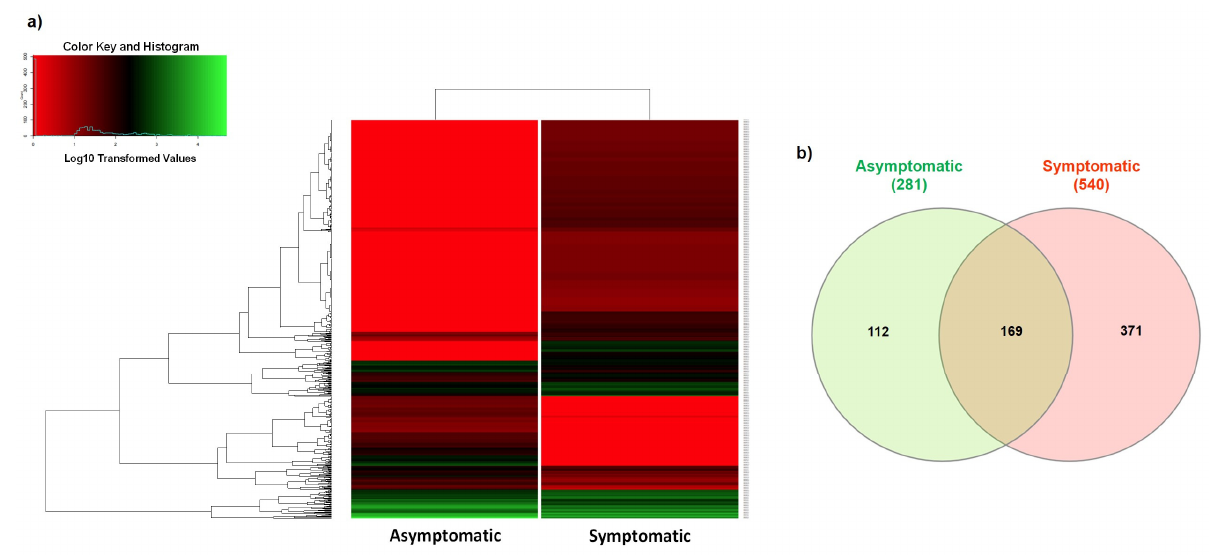
Figure 2. Analysis of DEGs in the Persian lime transcriptome. ( a ) Hierarchical clustering of 652 DEGs identified in the Persian lime transcriptome for two conditions (asymptomatic and symptomatic HLB) is shown. The heat map indicates downregulated transcripts in red, upregulated transcripts in green, and transcripts with similar expression patterns in black. ( b ) Venn diagram for DEGs in HLB-asymptomatic and HLB-symptomatic leaves. Numbers in the intersection indicate the number of detected genes with at least one read (gene label) in those intersections.